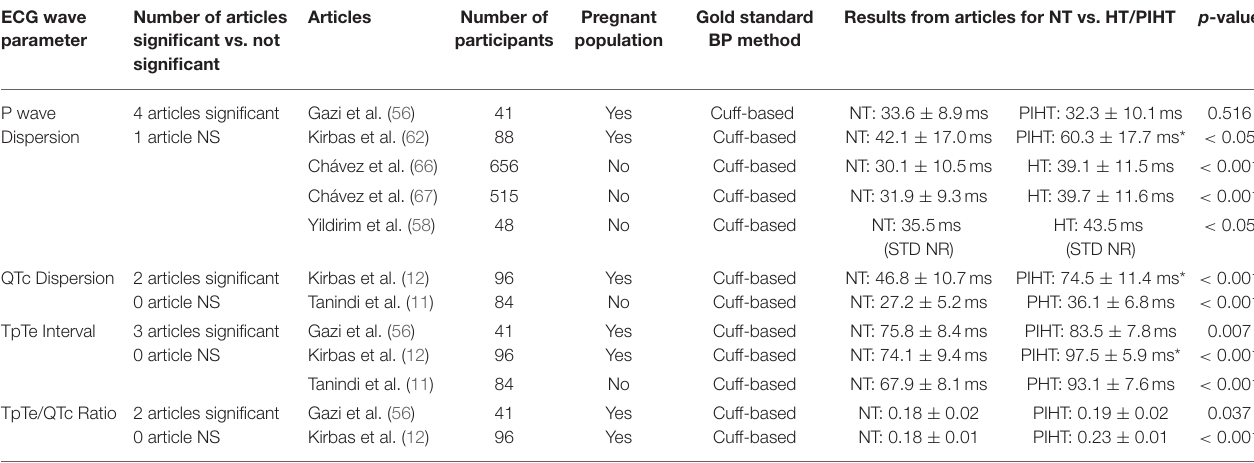
TABLE 2 | Summary of the four ECG wave parameters with the greatest number of articles without comorbidities or confounders that found significant changes with elevated blood pressures. Articles Number of Pregnant Gold standard Results from articles for NT vs. HT/PIHT p ECG wave Number of articles participants population BP method parameter significant vs. not significant